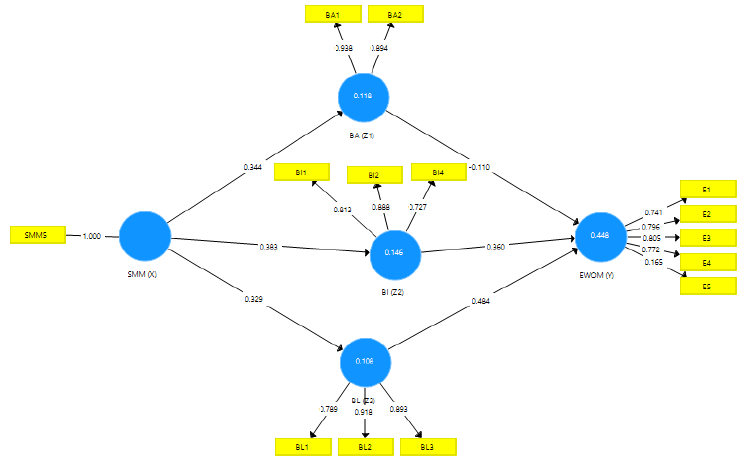
Fig. 4. Diagram of the Output Path Following the Removal of Indicators from Variables